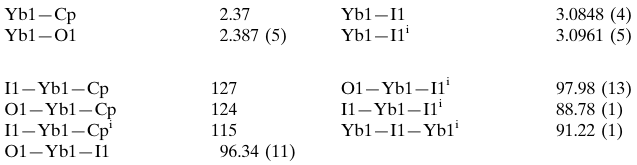
Selected geometric parameters (A˚ , (cid:1) ). Cp is the calculated centroid of atoms